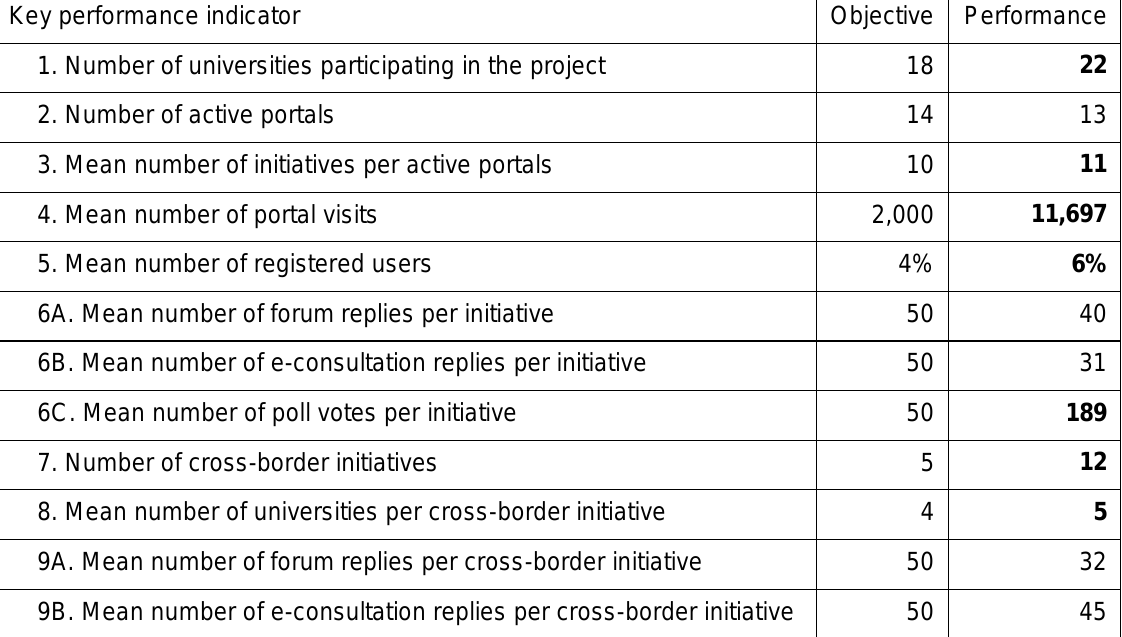
Table 1: KPI results of the final period of the project Key performance